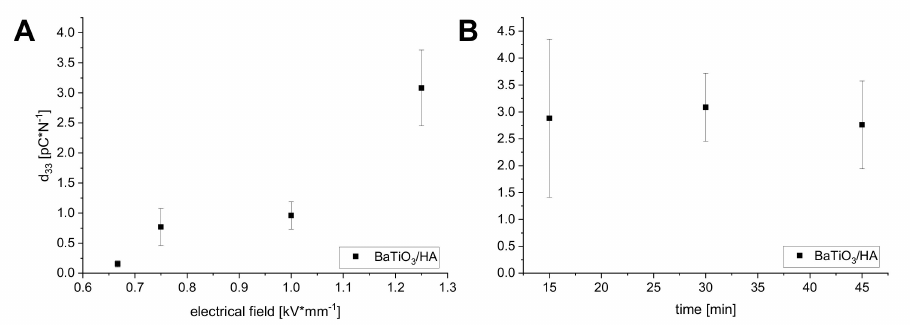
Figure8. Piezoelectriccoe ffi cientd 33 independenceoftheappliedpolarizationfield( A )andpolarization time ( B